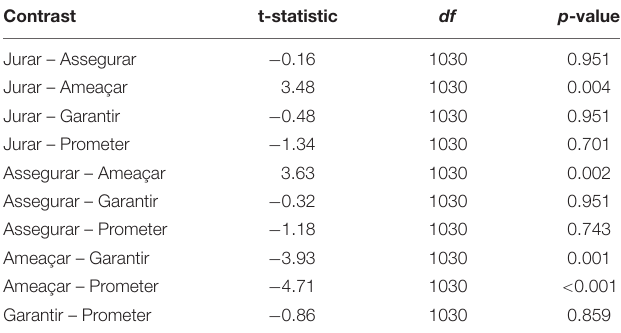
TABLE 3 | Pairwise Sidak-corrected contrasts for subject control